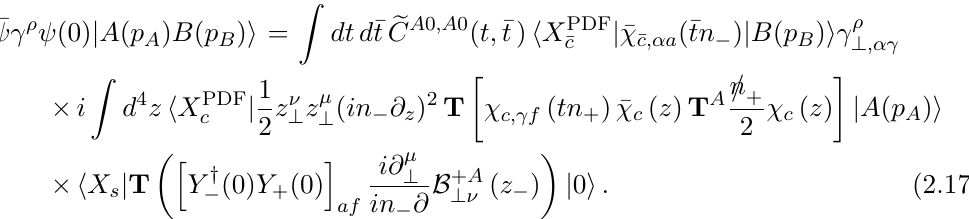
collinear loop integrals. Concretely, consider the DY matrix element with an insertion of the above